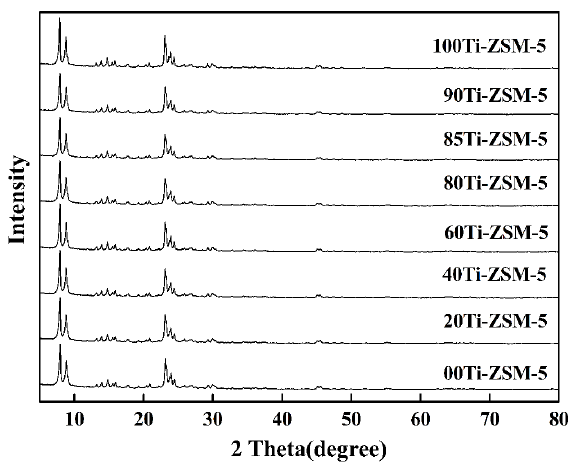
ff ractograms of hierarchical porous Figure 1. X-Ray diffractograms of hierarchical porous Ti-ZSM-5. Figure 1. X-Ray di